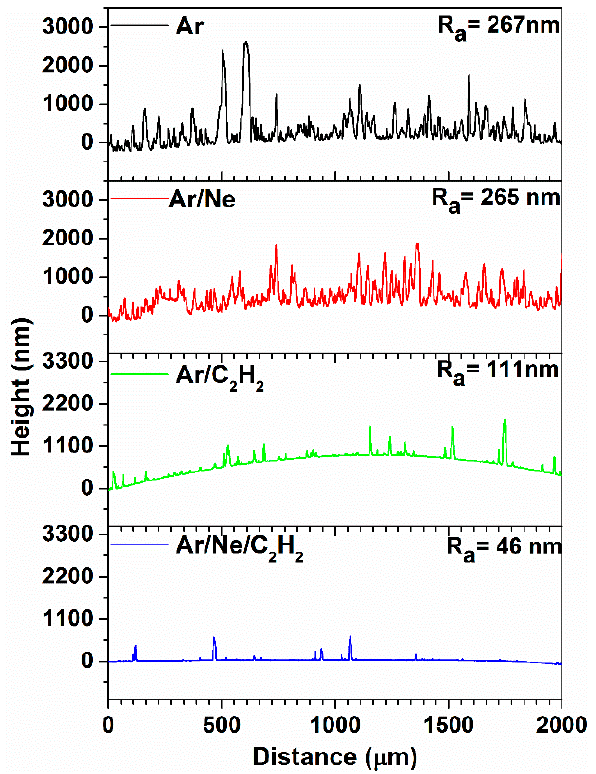
Figure 3. Typical roughness profiles of each coating prepared according to four process conditions presented in Table 1.